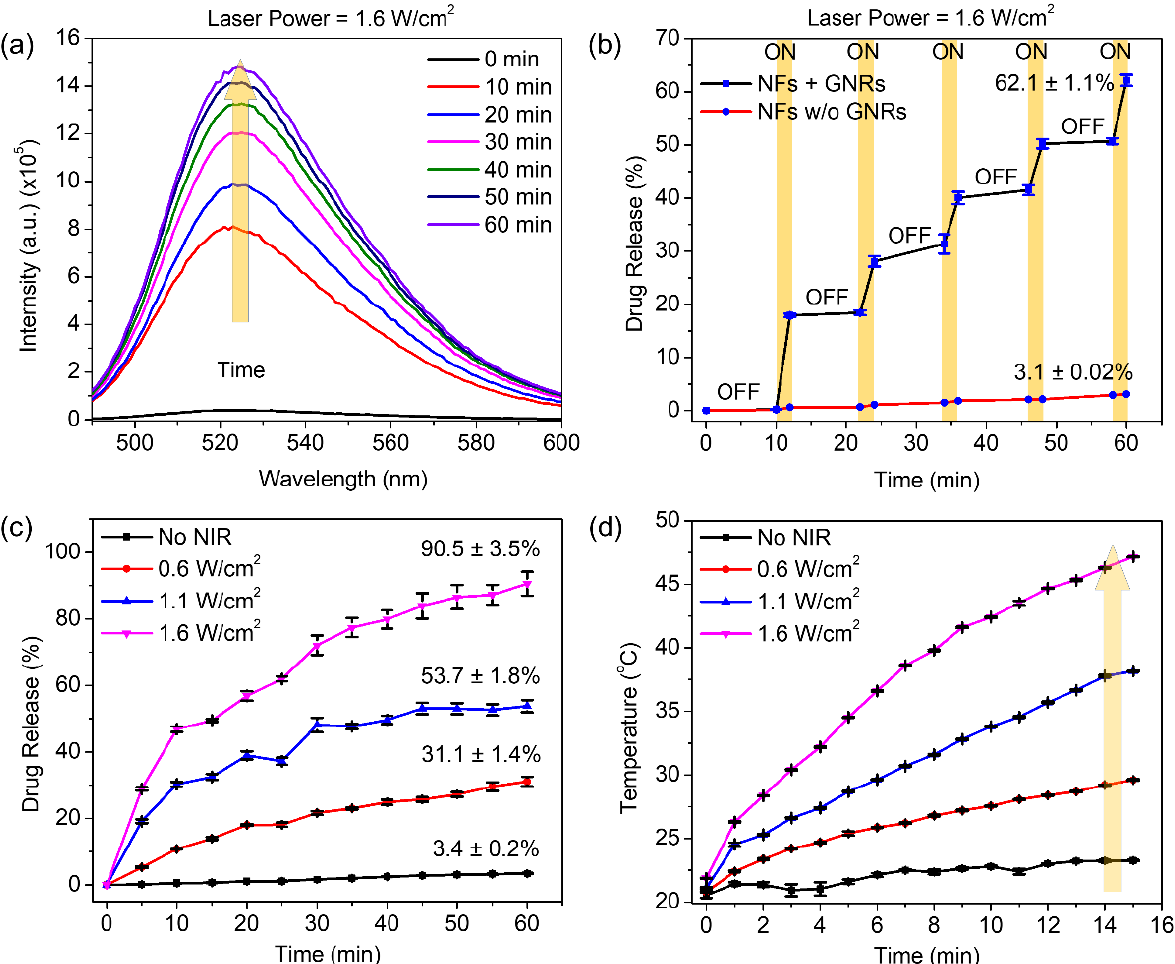
Figure 5. ( a ) Fluorescence intensity of drug release. ( b ) Pulsatile drug release from the nanofibers through the cyclic on–off of NIR light irradiation at different time intervals. ( c ) Cumulative drug release from the matrix of the nanofibers with different laser powers. ( d ) Rate of change in temperature for different laser powers.